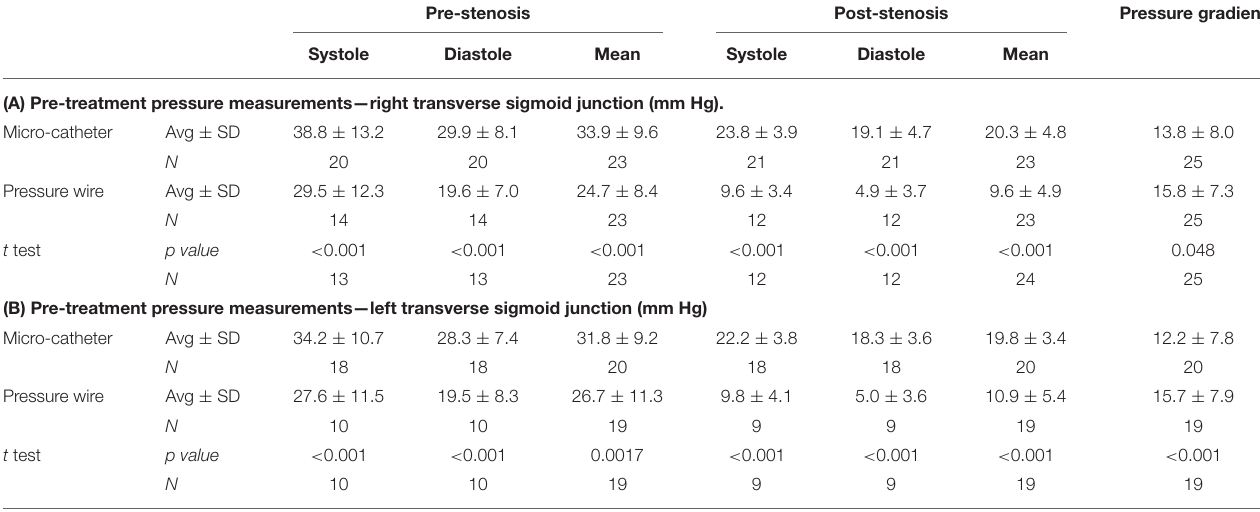
TABLE 2 | Venous pressure measured with the microcatheter and the pressure wire before stent treatment. Pre-stenosis Post-stenosis Pressure gradient Systole Diastole Mean Systole